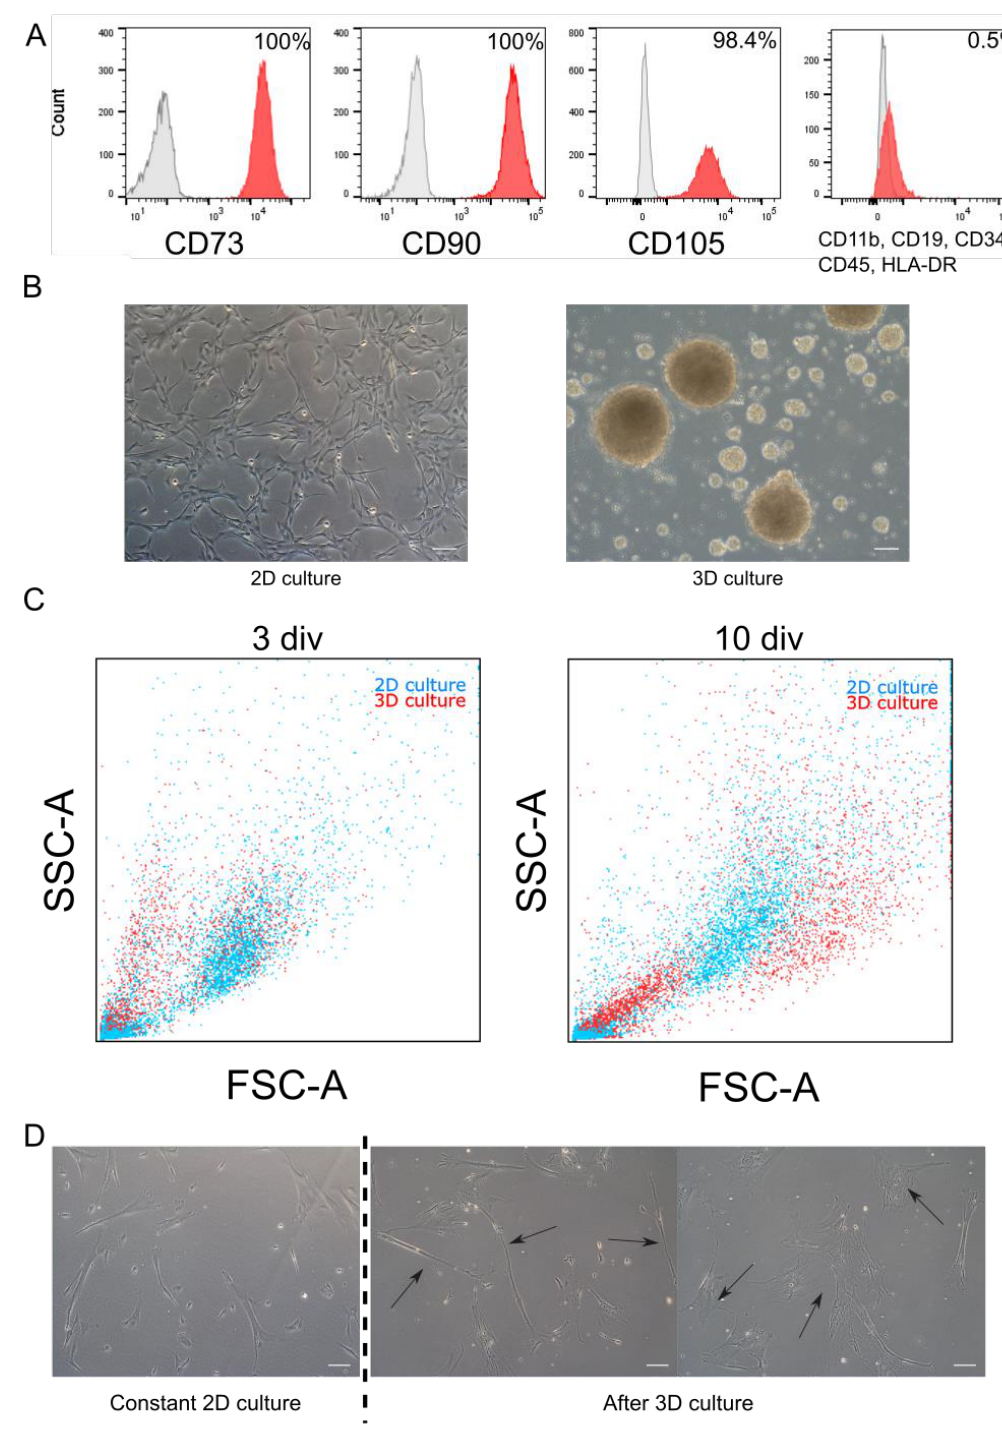
Figure 1. Morphology and phenotype of WJ-MSC cultured in monolayer and as spheroids. ( A ). Flow cytometry analysis. Initial population of WJ-MSC used to experiments expressed specific MSC markers (CD73, CD90, and CD105) and less than 1% of WJ-MSC expressed negative markers (CD11b, CD19, CD34, CD45, and HLA-DR). Red histogram—analyzed marker, grey histogram—isotype control. ( B ). Morphology of 2D and 3D cultured WJ-MSC—monolayer culture of WJ-MSC from 4th passage (up) and WJ-MSC 4 div after formed spheroids (down). ( C ). Flow cytometry—Forward scatter (FSC) and Side scatter (SSC) analysis for 3D culture (spheroids) and 2D (monolayer). Three days in vitro (div) and 10 div after sphere induction, there were differences in size of cells between 2D and 3D culture. ( D ). Different morphology of cells cultured as spheroids after reseeding into 2D conditions. Right: WJ-MSC cultured constantly in 2D for 8 passages. Center and left: WJ-MSC from 3D reseeded to 2D condition—visible two different types of morphology: narrow and small (center) and flat and broad (left) cells. White scalebars represent 100 µ